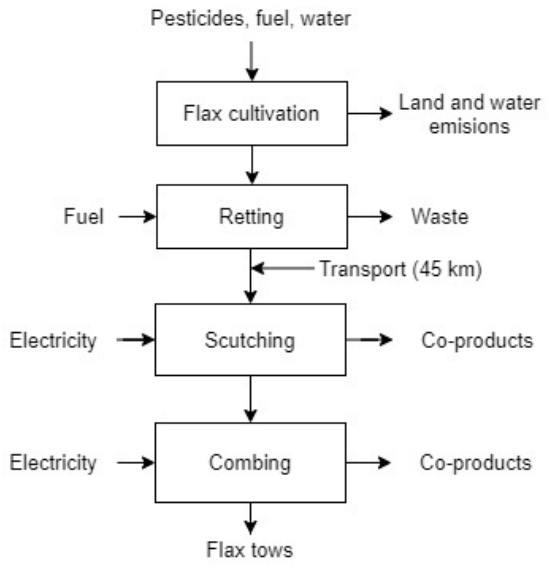
Figure 1. Flow chart of flax tows production.